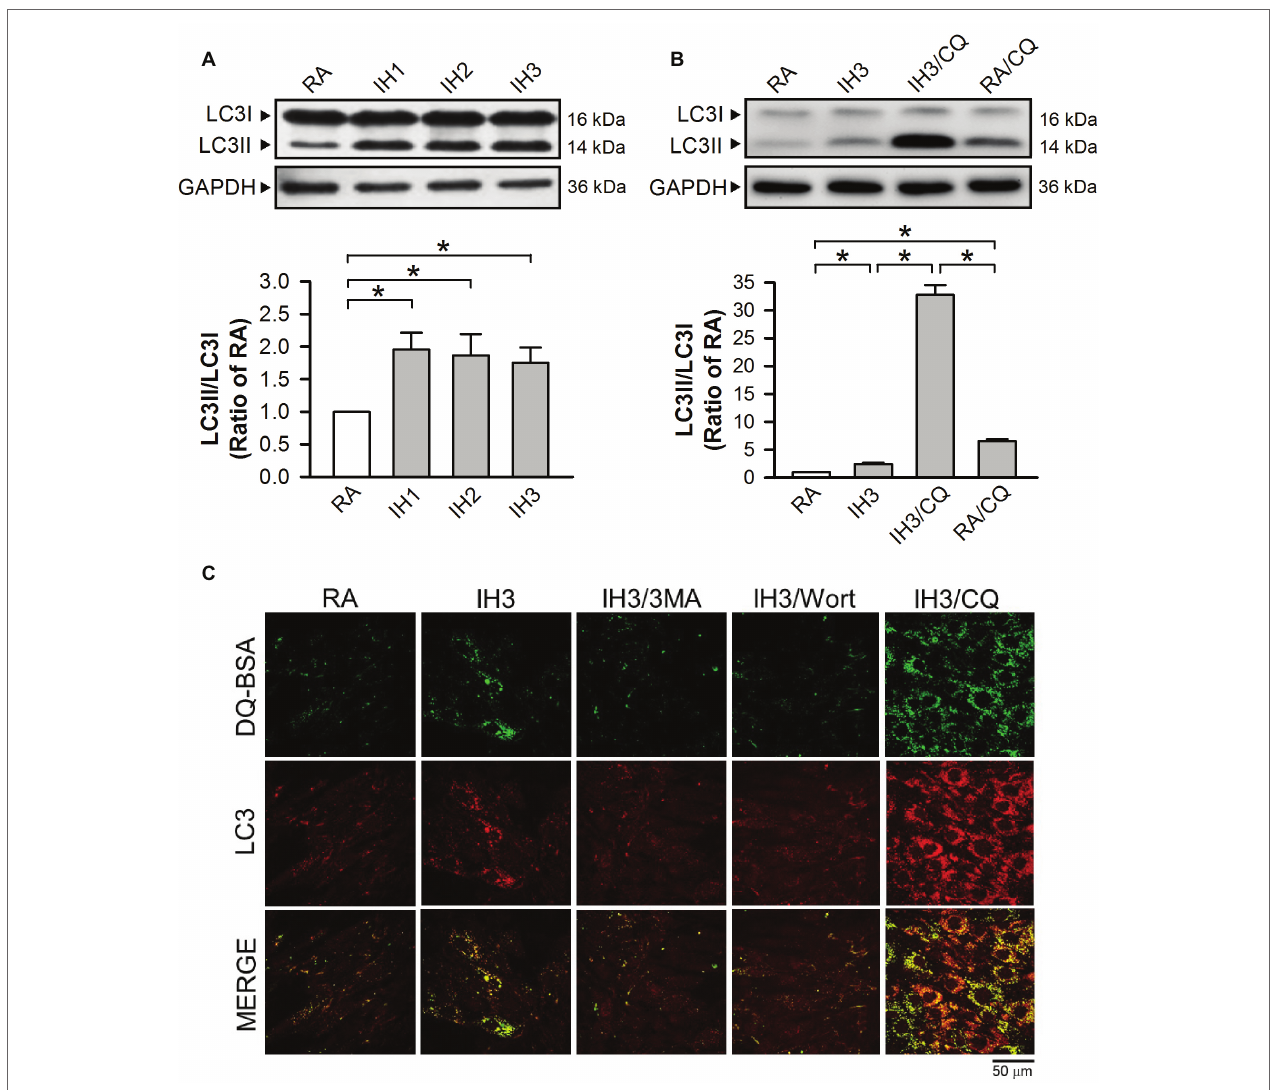
FIGURE 3 | IH attenuates autophagy-associated ER stress in H9c2 cells. (A) Cells were treated with RA or IH for 1–3 days, and then harvested for detecting the LC3 protein levels. A representative result of LC3II and LC3I immunostaining in H9c2 cells determined by Western blot analyses. The protein levels of LC3II/LC3I were determined and expressed as ratio over the RA group. (B) Cells were treated with RA, IH for 3 days, IH for 3 days combined with chloroquine (5 μM), or RA combined with chloroquine (5 μM). A representative result of LC3II and LC3I immunostaining in H9c2 cells determined by Western blot analyses. Quantitative results of LC3I and LC3II protein levels were adjusted with the GAPDH protein level and the LC3II/LC3I value was expressed as ratio over the RA control group. (C) Cells were analyzed by confocal microscopy using DQ™-Green BSA. Autolysosomes were identified as LC3-positive ( red )—green DQ-containing structures ( green ). The increased levels of autolysosomes were observed in IH-treated H9c2 cells. Cells were treated with RA or IH for 3 days followed by 3-methyladenine (50 μM), wortmannin (5 nM), or chloroquine (5 μM) for additional 24 h, and then analyzed by confocal microscopy using DQ™-Green BSA. The increased levels of autolysosomes were reduced by 3-methyladenine or wortmannin. Values are means ± SEMs. ( n = 4). * p < 0.05. 3MA, 3-methyladenine; CQ, chloroquine; IH, intermittent hypoxia; RA, room air; Wort,